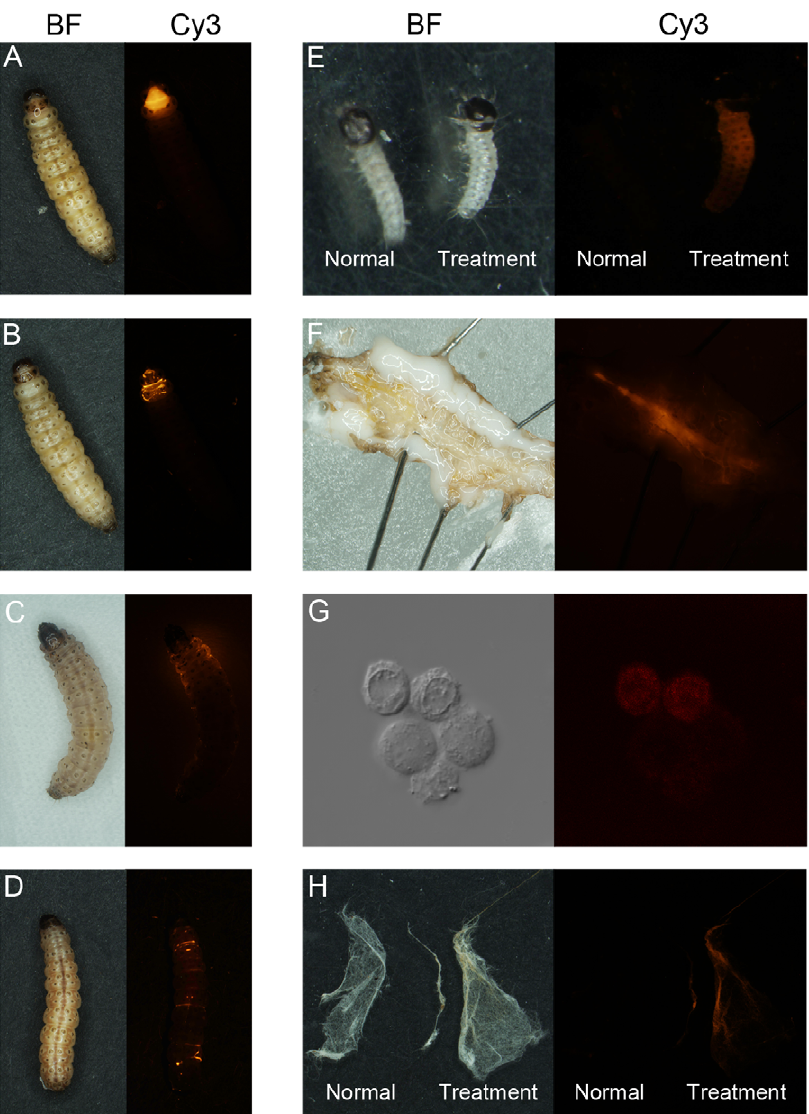
Figure 4. The fluorescent labeled dsRNA dropping test. The fluorescent labeled dsRNA (0.5 m l of 5 m g/ m l) was topically applied on the protergum of the ACB mature larva. ( A ) The droplet was seen at the surface of the body wall just after dropping; ( B ) 30 min later, the droplet had already penetrated the body wall, and spread to the head and other thoracic segments; ( C ) 2 h later, the fluorescent dsRNA had spread to abdominal segments; ( D ) 4 h later, the fluorescence was seen in the whole body; ( E ) When the egg was soaked in the solution with 50 ng/ m l fluorescent labeled dsRNA for 2 h, the newly hatched larvae were labeled with fluorescent; The fluorescence was observed in the gut( F ), hemocytes ( G ) and silk fiber ( H ). From A to H , the left panel of each pair was on bright field (BF) and the right panel of each pair was on 559nm (Cy3). Image magnification: A–D , F , H (10 6 ); E (40 6 ); G (400 6 ).